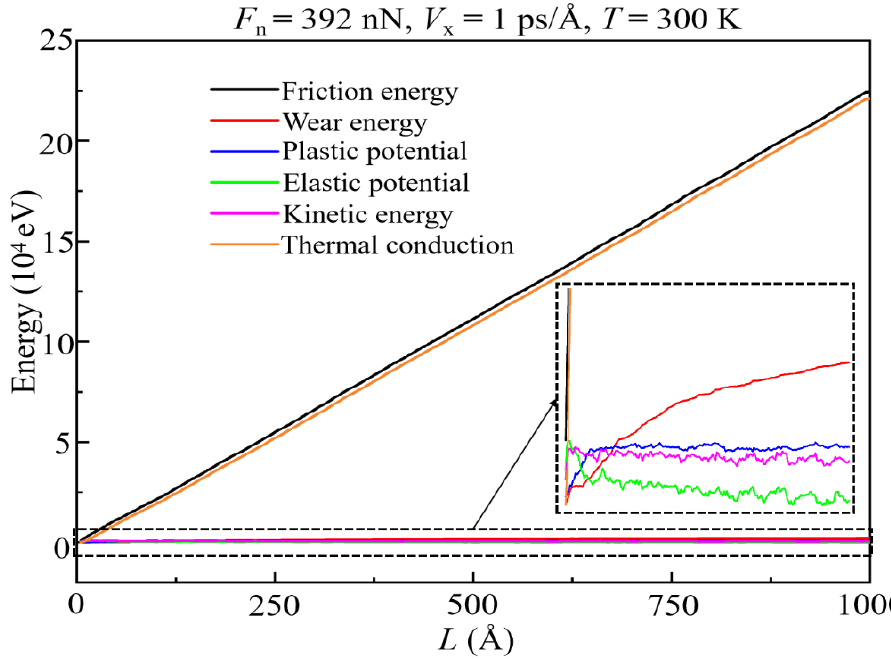
Figure 11. The evolution of various energy dissipation forms with sliding distance.